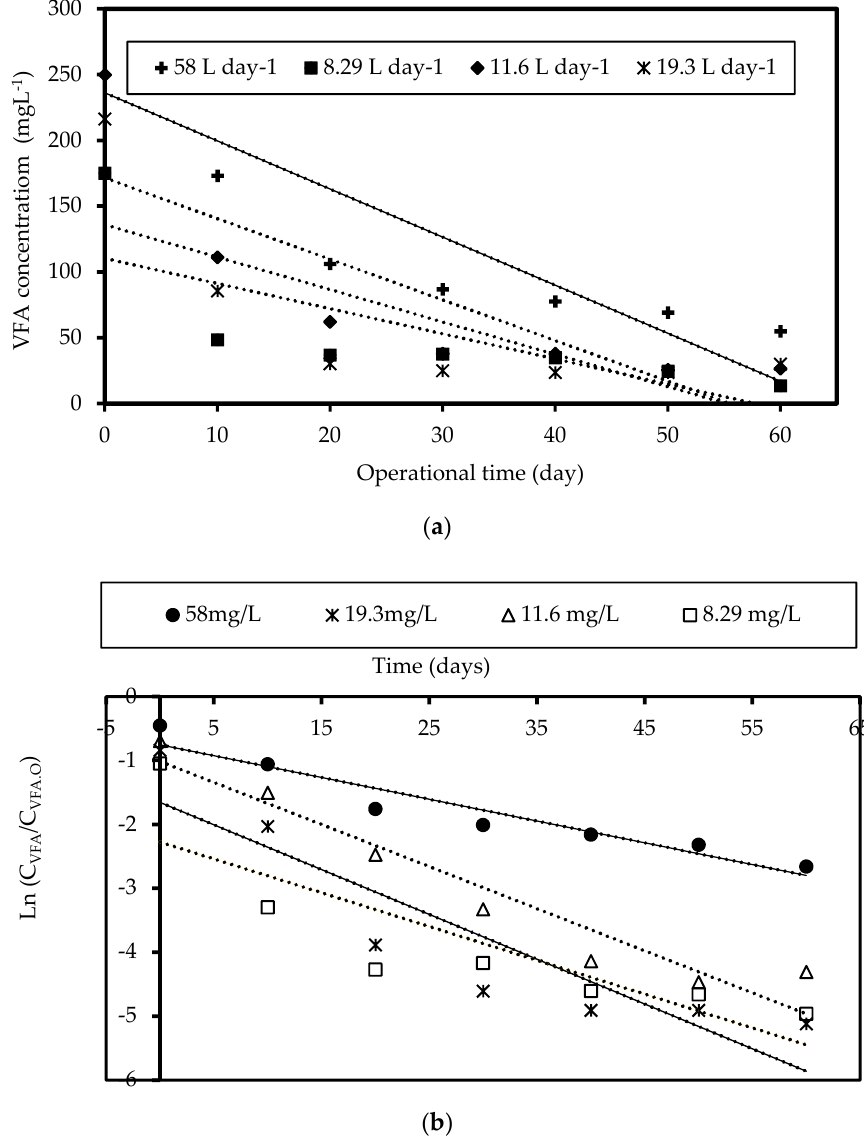
Figure 3. Determination of ( a ) k max . VFA and ( b ) k s . VFA .